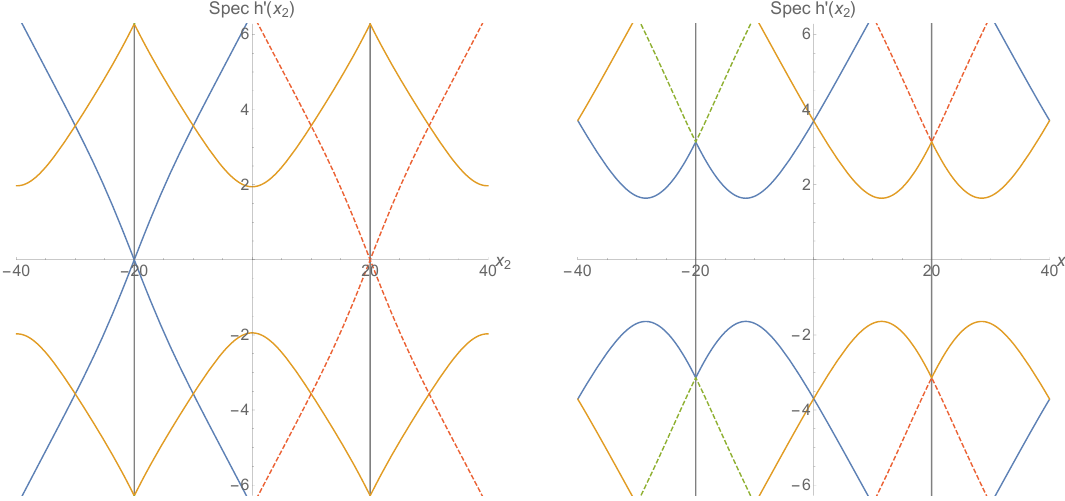
Figure 1 . Typical spectrum of the snapshot Hamiltonian h 0 ( x 2 ) . The green-dashed, blue- solid, orange-solid and red-dashed curves correspond to momentum eigenstates with p 1 L 1 / 2 π = − 2 , − 1 , 0 , 1 , respectively. (We will explain the difference of the solid/dashed curves in section 4.3.) Domain walls are put on the gray vertical lines. The gauge potential monotonically decreases inside the region separated by the domain walls as A 1 ( x 2 ) = − Bx 2 + A 1 (0) ( | x 2 | < L 2 / 2) and monoton- ically increases outside as A 1 ( x 2 ) = + B ( x 2 ∓ L 2 / 2) + A 1 ( ± L 2 / 2) ( L 2 / 2 < | x 2 | < L 0 B = 2 · (2 π/L 1 L 2 ) . Parameters are chosen as L 1 = 1 , L 2 / 2 = 20 , | m | = 2 , (cid:15) = 8 so that the hierar- chy (4.19) is satisfied. In the left panel, the holonomy a = A 1 (0) L 1 / 2 π is an integer, invalidating adiabatic approximation at the domain walls. In the right panel, the holonomy is shifted to a half-integer, validating adiabatic